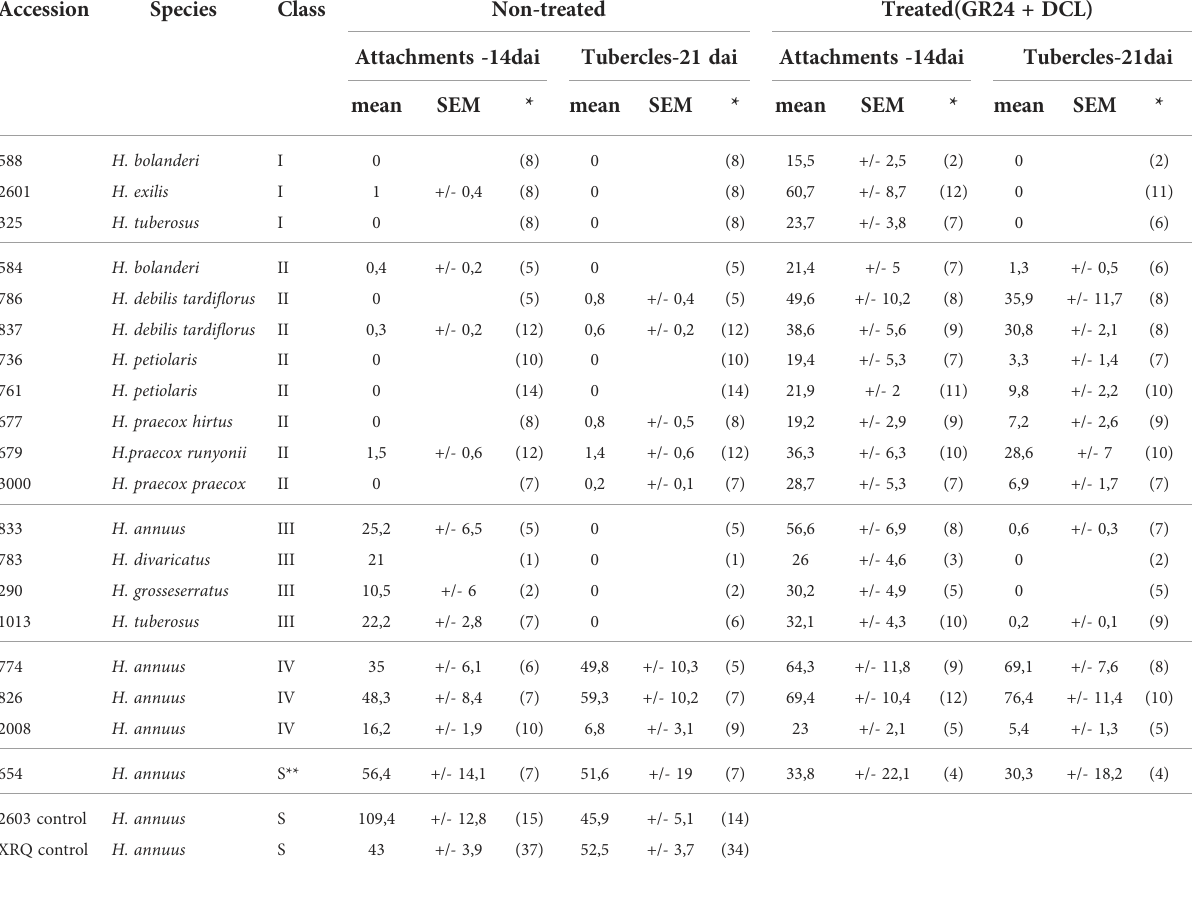
TABLE 3 Quantitative data of the phenotyping in rhizotrons of 18 wild Helianthus accessions from 9 species at the attachment and tubercle stages, using the broomrape race